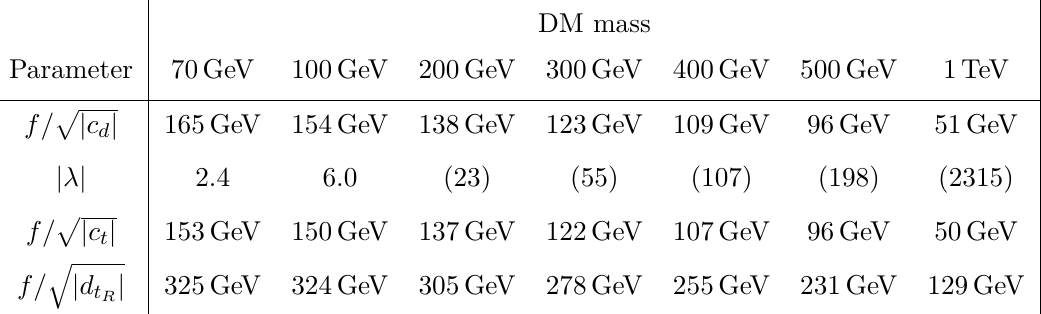
Table 3 . 95% CL bounds that derive from the tX + E miss